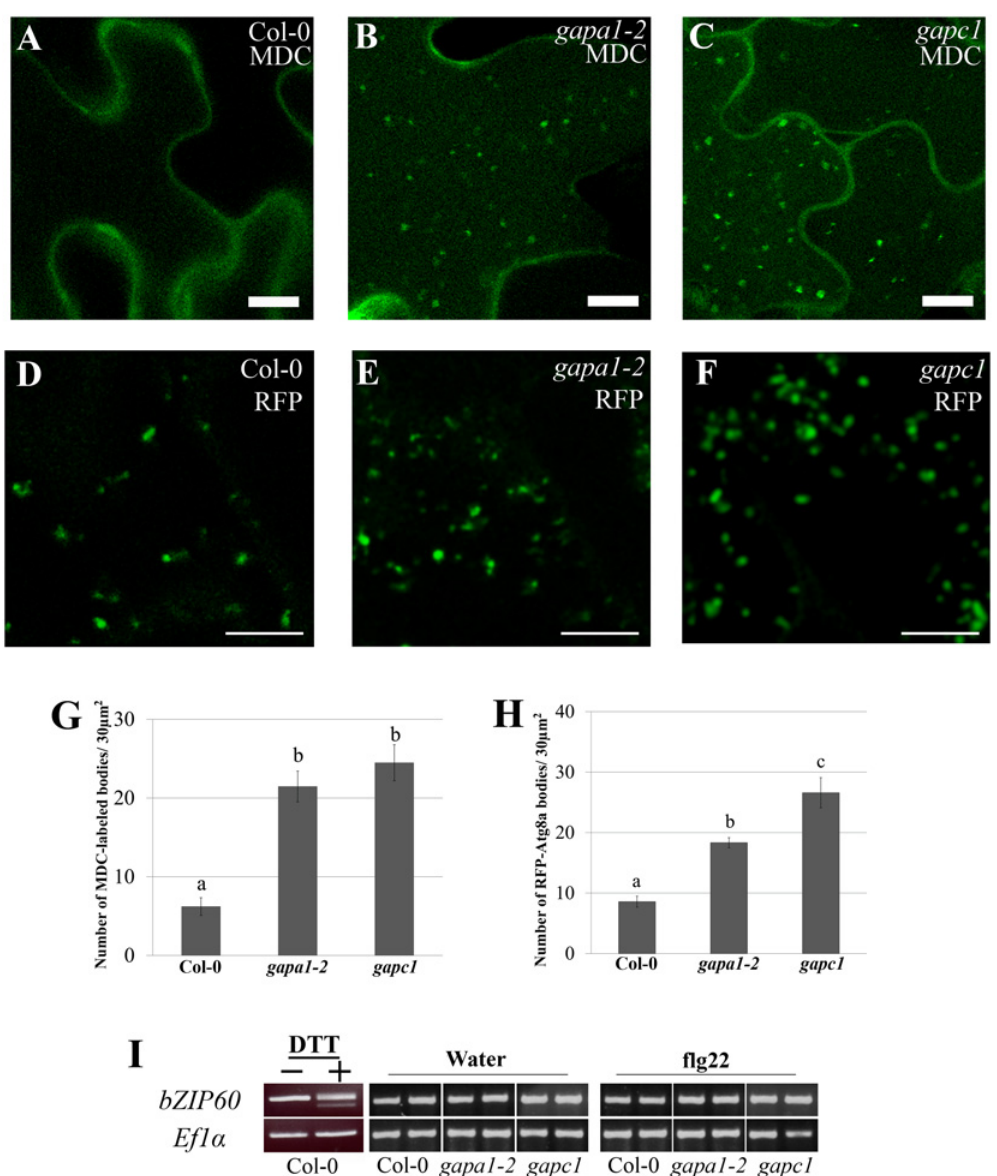
Fig 8. gapa1-2 and gapc1 exhibit enhanced basal autophagy. (A-C) Confocal micrographs of Col-0, gapa1-2 , and gapc1 KO lines show optical sections of leaves from two-week-old plants grown in full MS. Seedlings were assayed with the fluorescent probe MDC. Autophagosomes were stained using 50 μ M MDC for 3 h. The gapa1 and gapc1 KO lines had many MDC-labeled bodies when grown in full MS, but wild-type Col-0 did not exhibit a significant number of basal MDC-labeled bodies. One μ M Concanamycin A or the equivalent amount of solvent DMSO was added 15 h prior to imaging. Bar = 10 μ m. (D-F) Confocal micrographs of 10 day old Col-0, gapa1-2 , and gapc1 KO lines transiently transfected with tRFP-Atg8a to visualize cytosolic autophagosomes. Transiently transfected seedlings all exhibit tRFP-Atg8a labeled autophagosomes, with greater numbers present in gapa1-2 and gapc1 KOs. Bar = 10 μ m. (G-H) Images depicted above were quantified using ImageJ to calculate the number of MDC (G) or tRFP-Atg8a (H) labeled bodies in an area of 30 μ M 2 . Both gapa1-2 and gapc1 seedlings have significant increases in autophagosome number relative to Col-0. Statistical differences were calculated using Fisher ’ s LSD test ( α = 0.05) following a significant F-statistic to compare means of all genotypes. Values represent means ± SE (n = 6). (I) The unfolded protein response (UPR) triggered by ER stress is not constitutively activated in gapa1-2 or gapc1 KOs. Semi-quantitative RT-PCR analysis of bZIP60 mRNA demonstrates no cleavage product, indicating that UPR is not activated. The positive control on the left was induced in Col-0 leaves by infiltration with 2 mM DTT. ELONGATION FACTOR 1 α ( EF1 α ) served as a control for equal mRNA